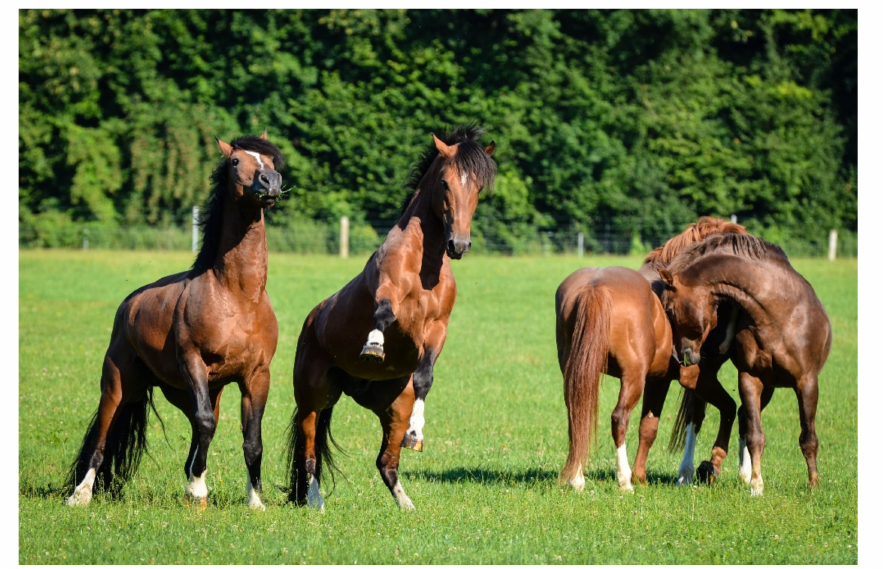
Figure 1. A group of stallions enjoying social contact on pasture (Agroscope, Schweizer Nation- algestüt, Switzerland).